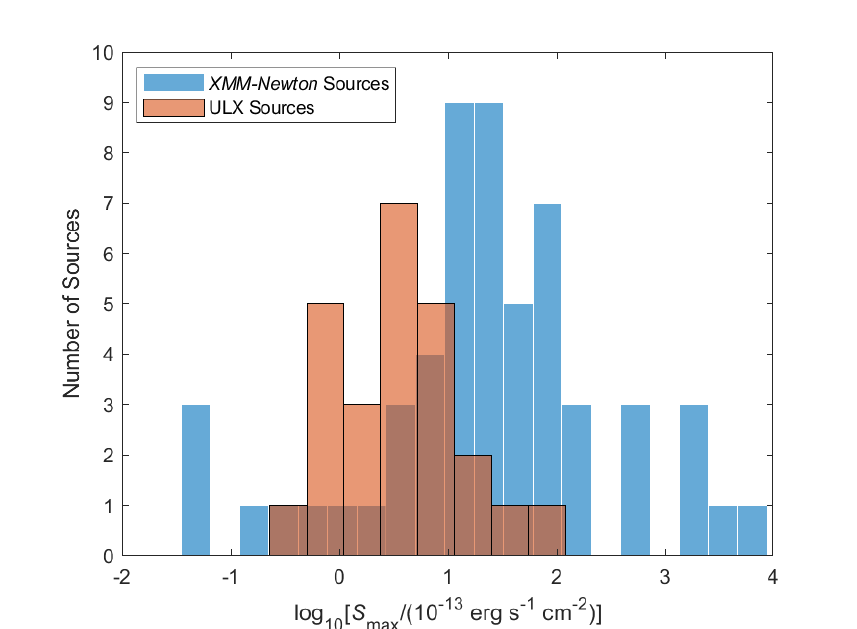
Figure 1. Flux histograms. The SMC XMM-Newton and ULX data sets appear to be dissimilar. The ULX sample clearly peaks at lower flux values, and its secondary peak is located at the lower tail of the distribution, contrary to the secondary peak of the SMC XMM-Newton data set.